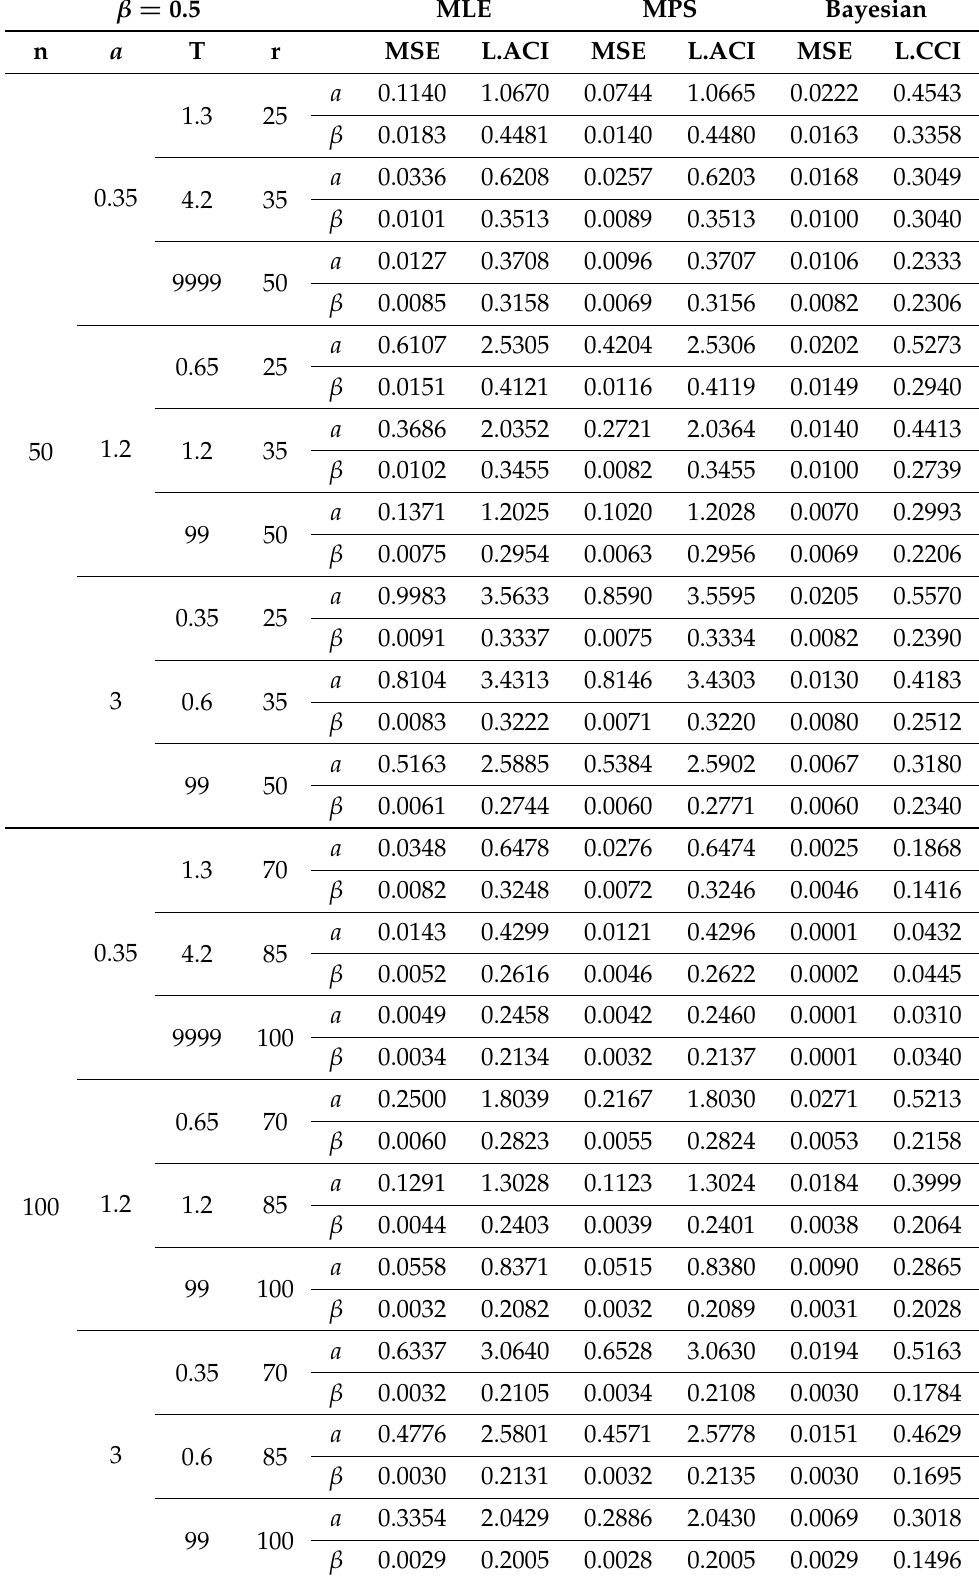
Table 5. MSE and length of CI for MLE, MPS, and Bayesian estimation for parameter of the TCP-ITL based on hybrid censored samples: when β =